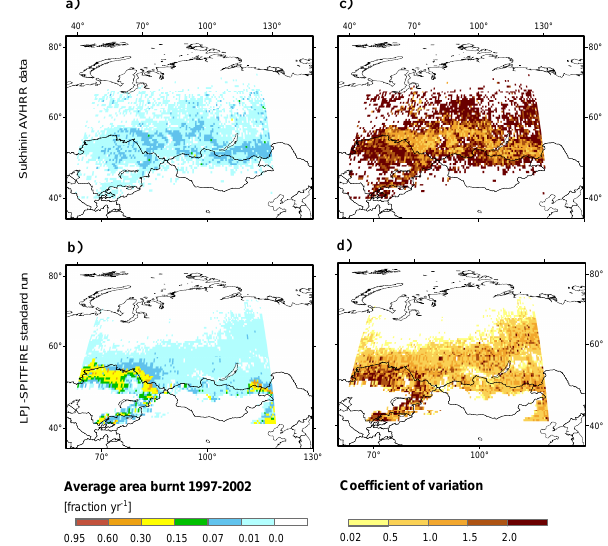
Fig. 9. Comparison of (a) observed (Sukhinin et al., 2004) and (b) simulated annual average area burnt in central Siberia; (c) , (d) observed and simulated coefficients of variation in area